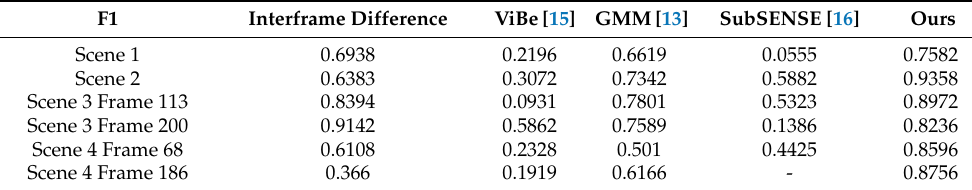
Table 3. F1 comparison of algorithm results in different scenarios.